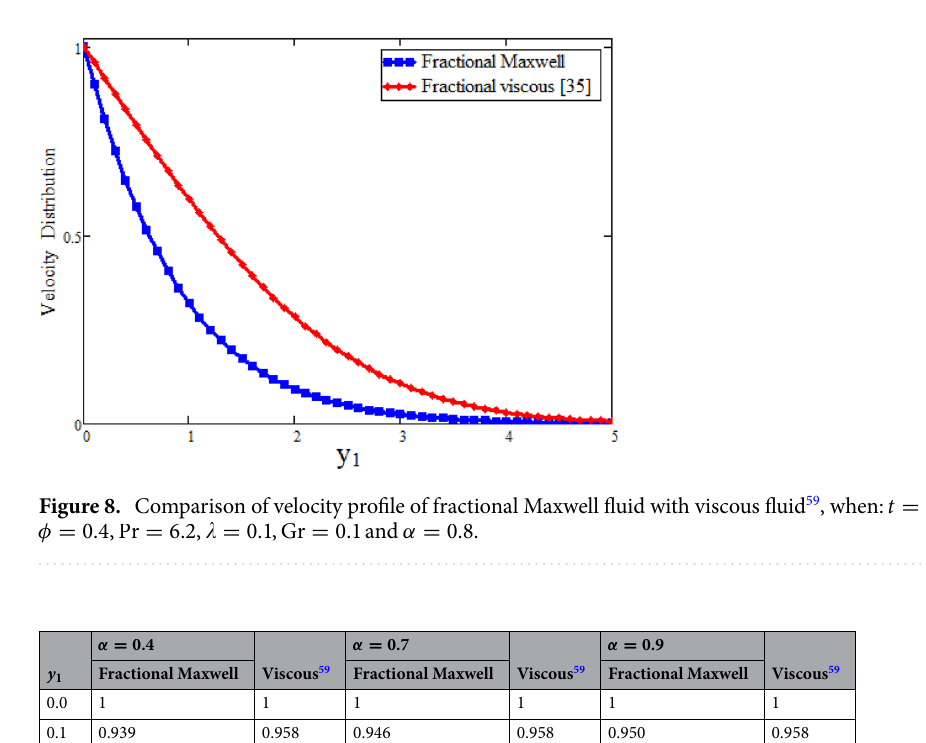
Table 3. Effect of fractional parameter on dimensionless